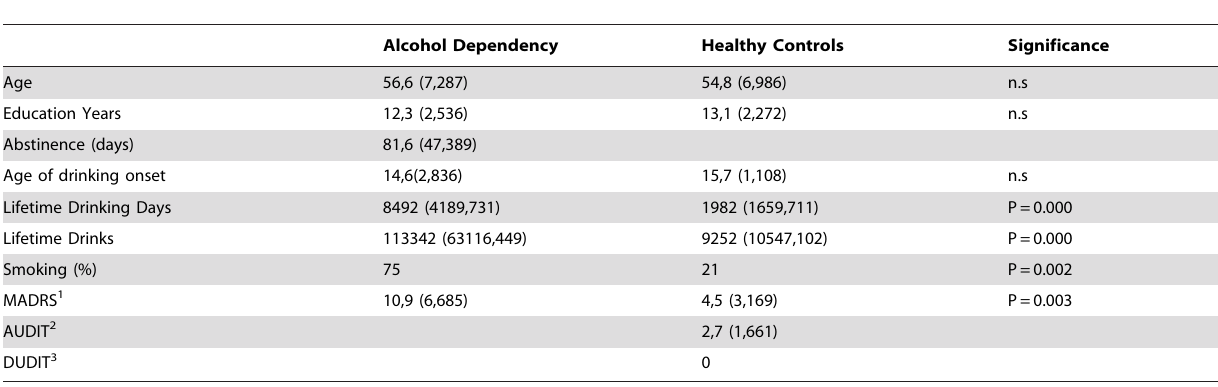
Table 2. Demographic and clinical data of the 39 subjects participating in the study, with values in parenthesis referring to 1 standard deviation.